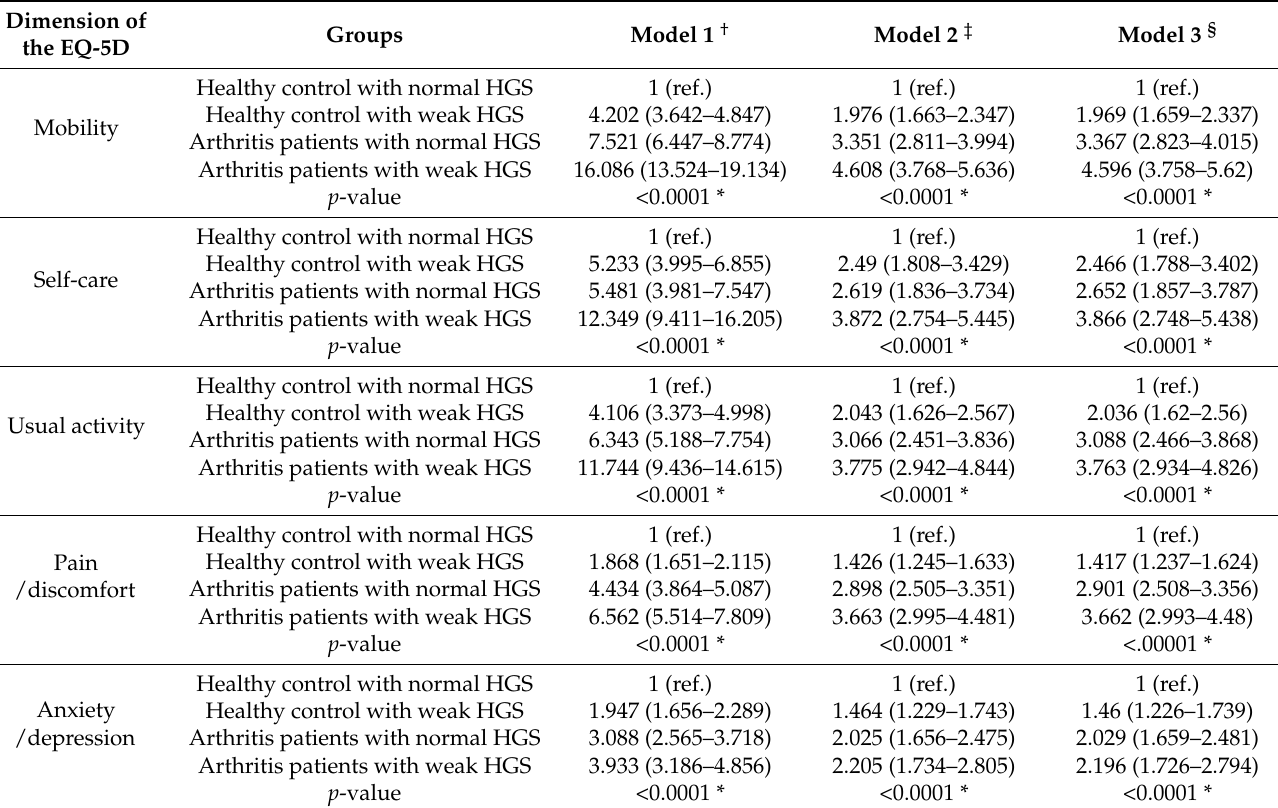
Table 4. Associations between weak HGS and impaired quality of life (five dimensions of the EQ-5D) in patients with arthritis and healthy